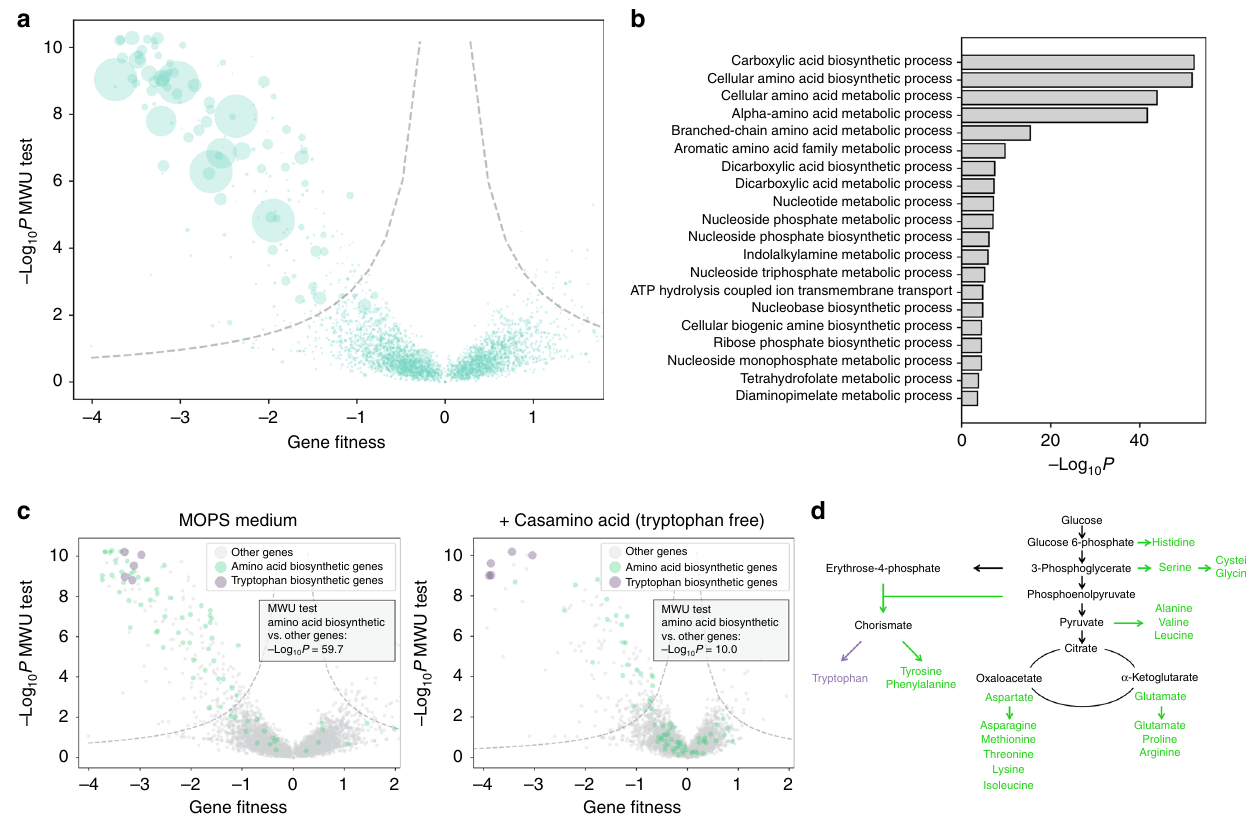
Fig. 5 CRISPRi screening dissects the E. coli metabolic network. a Volcano plot of gene fi tness in MOPS medium relative to − Log 10 P value from the two- tailed MWU test. Dashed lines represent the threshold (FDR = 0.05) for calling hits based on the screening score (see Methods). The size of the scatter is proportional to the 1/OD 600 value of the relevant gene knockout reported with the Keio collection 1 . b GO enrichment analysis of auxotrophic genes identi fi ed by CRISPRi screening in MOPS medium. P values are derived from two-tailed Fisher exact test. c Comparison of gene fi tness in MOPS medium with casamino acids (right) or a single carbon source (left) for E. coli . 78 genes responsible for amino acid biosynthesis are highlighted in green, whereas the fi ve genes ( trpABCDE ) forming a branched pathway leading to tryptophan biosynthesis are in purple. The differences between fi tness of amino acid biosynthesis genes and all other genes were quanti fi ed via the two-tailed MWU test ( P , 10 − 10.0 with vs. 10 − 59.7 without casamino acid addition). d Schematic of E. coli amino acid biosynthetic network. Green and purple elements denote amino acid biosynthetic genes and tryptophan biosynthetic genes ( trpABCDE ), respectively, corresponding to those highlighted in ( c